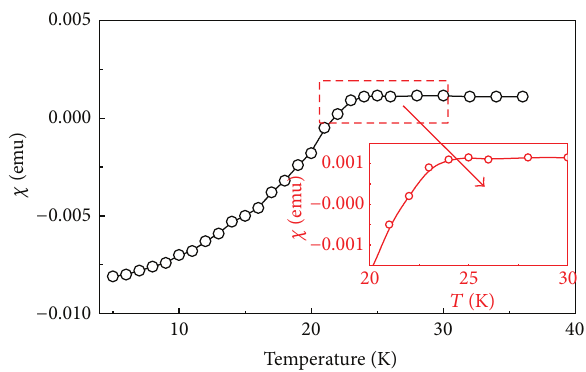
Figure 2: Magnetic susceptibility 𝜒 of treated Nd 1.85 Ce 0.15 CuO 3.961 as a function of temperature 𝑇 . The zero-field-cooled measurement is carried out under 10Oe. The insert shows enlarged susceptibility as a function of temperature near the transition. The powders are ammonothermally reduced at 54 ∘ C in sodium ammonia